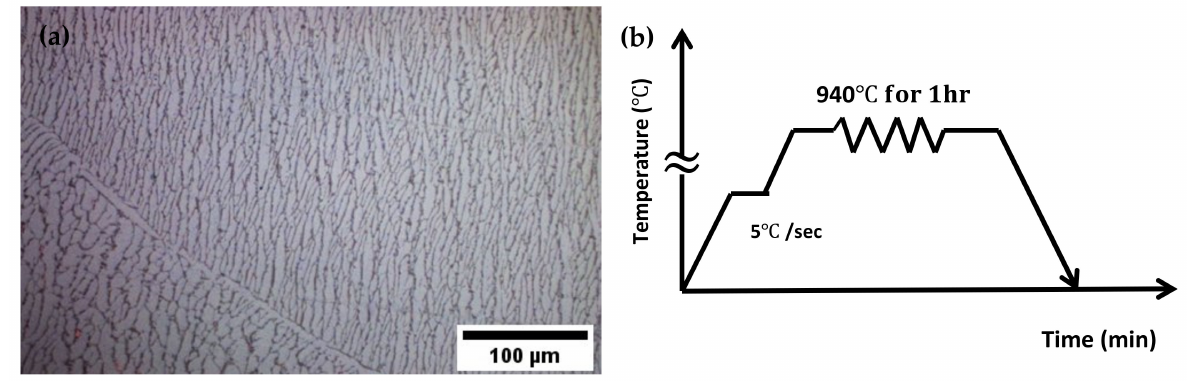
Figure 1. ( a ) Microstructure of Ti6Al4V-5Cu alloy after beta annealing treatment, ( b ) schematic presentation of beta annealing for hot deformation